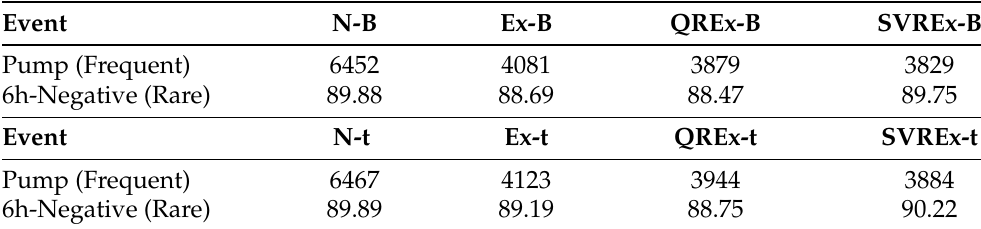
Figure 4. Murphy Decomposition for Events: ( a ) Murphy Decomposition Components per Model for Pump Event; ( b ) Murphy Decomposition Components per Model for 6h-Negative Event. Table 8. Profit–loss-based Evaluation: Profit